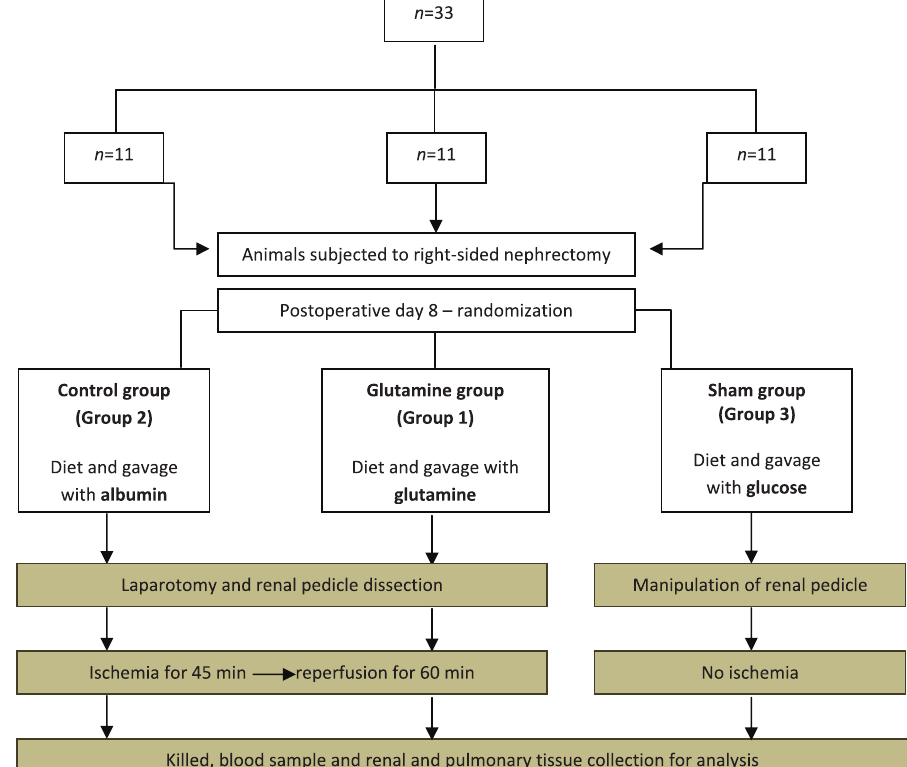
FIGURE 1 - Distribution of experimental animals within the study